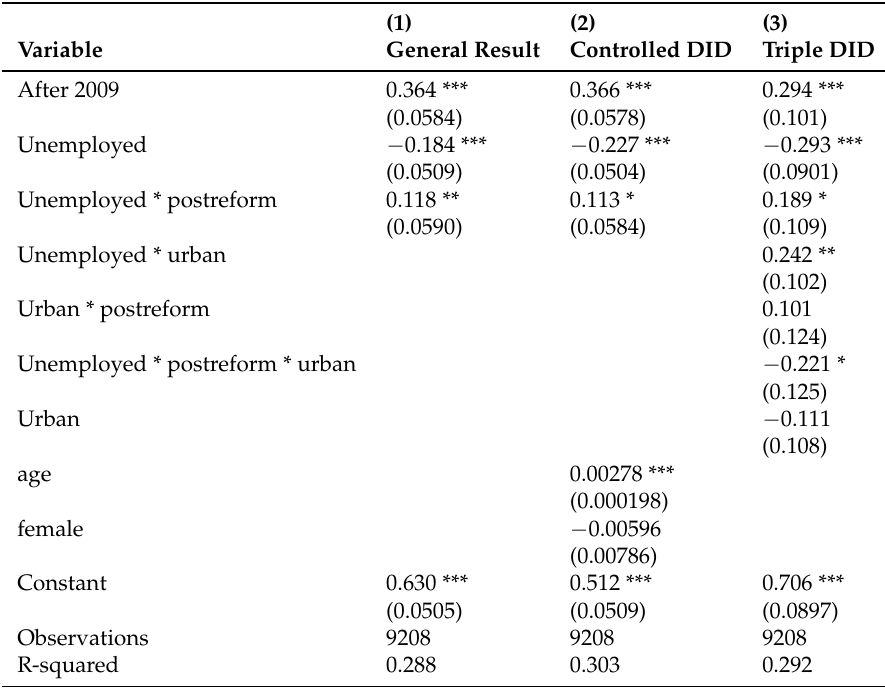
Table 8. Robustness check: treatment effect of health care reform on insurance